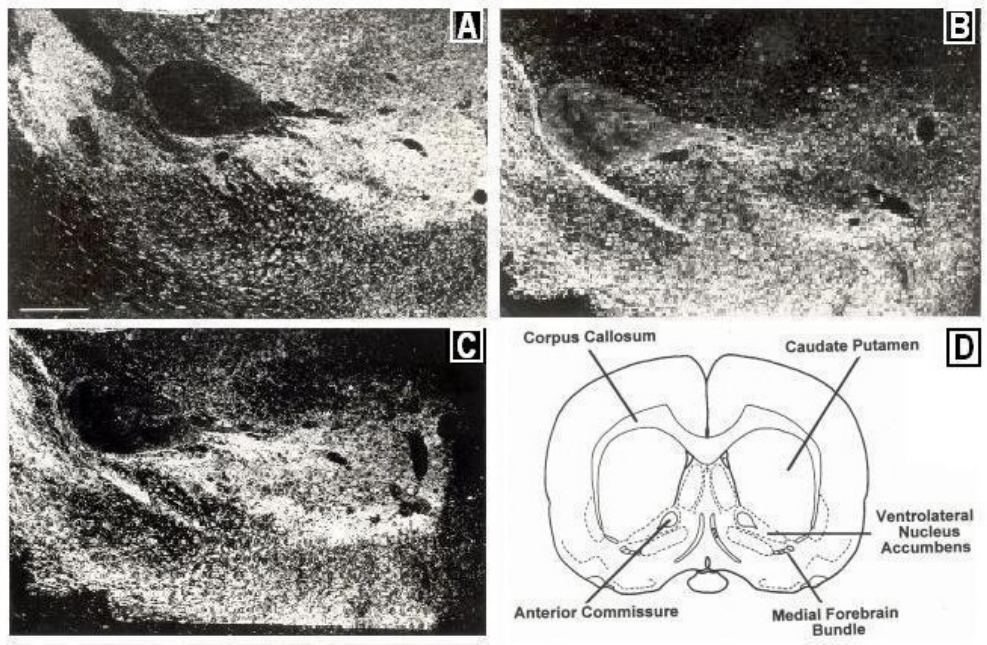
Figure 2. Immunocytographs of dopamine (DA) and serotonin (5-HT) in nucleus accumbens (NAc) (ventrolateral (vl)) of Sprague Dawley laboratory rats. Dark field photomicrographs show the distribution of ( A ) DA neurons, stained with tyrosine hydroxylase; two high density patterns of DA are apparent in the medial and lateral core, ( B ) 5-HT axons in the caudal one-third of NAcc; 5-HT was stained with a sensitive silver intensification procedure, thus axons and terminals are black, ( C ) 5-HT axons in DA neurons in NAcc at the site of the BRODERICK PROBE ® laurate biosensor. In ( B) , two low density patterns of 5-HT are apparent in the ventral and ventrolateral NAcc. High density 5-HT is seen in the perimeter around the core. A scale = 500 μ m as shown by the horizontal line in the bottom left part of Figure 2A, Direct efferent neurons derive from VTA to vlNAcc. ( D ) Coronal section of NAcc depicting vlNAcc is adapted with permissions from [21]. Copyright Elsevier Limited,